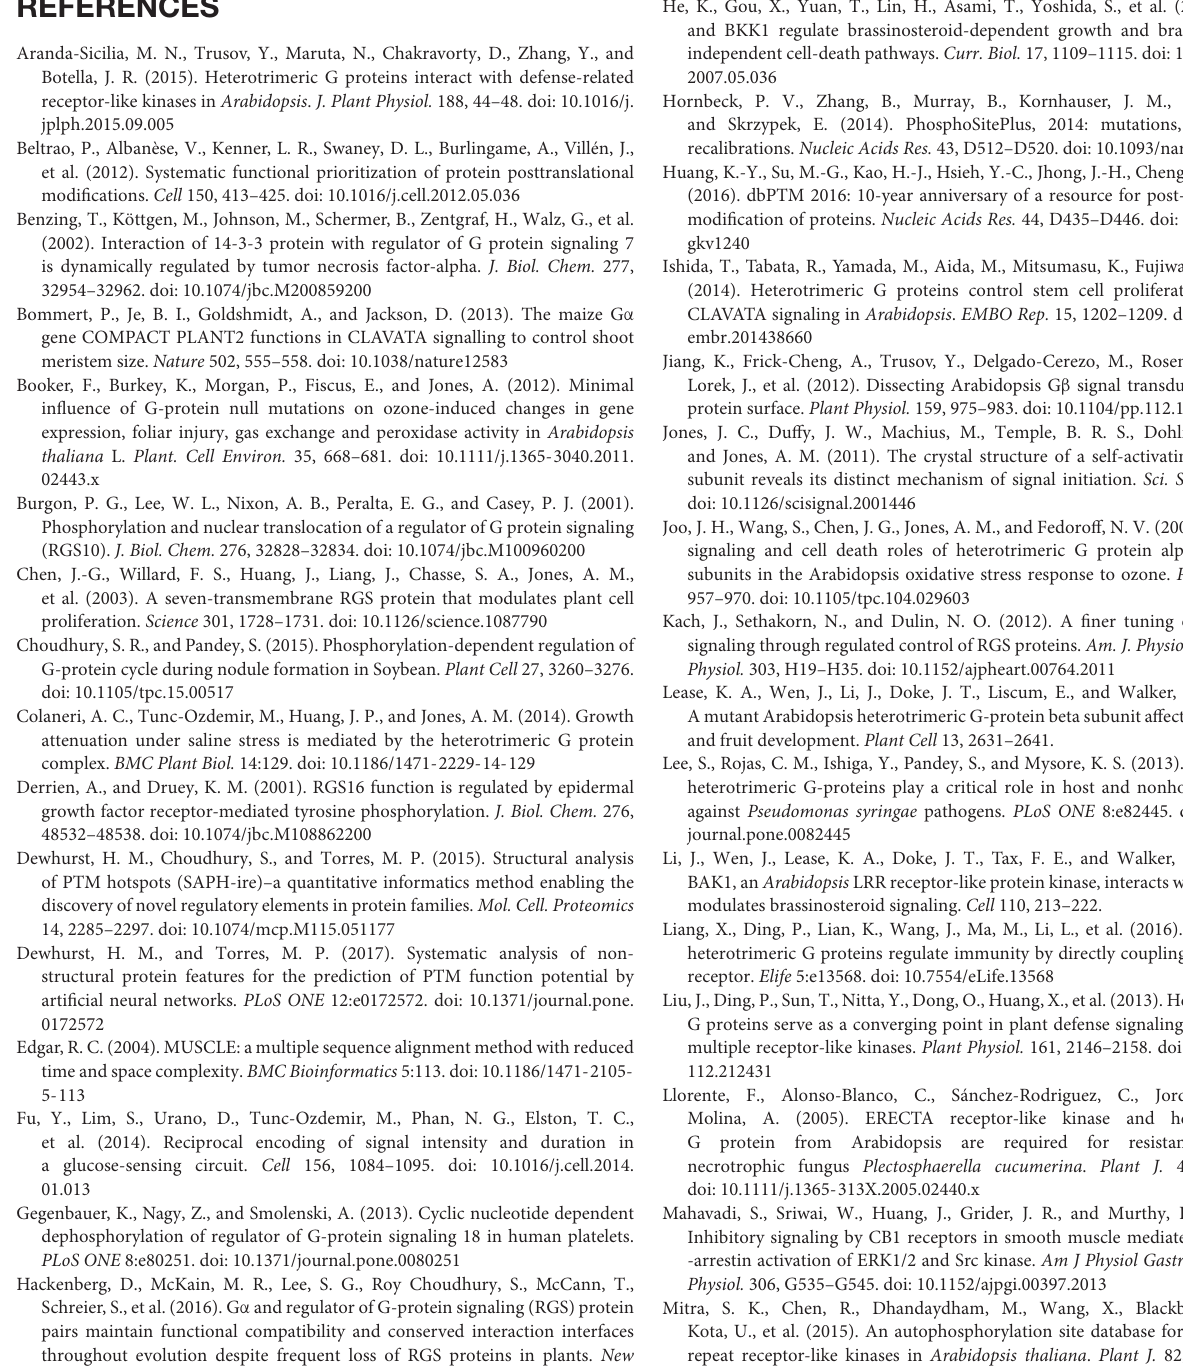
FIGURE S4 | Full rotation view of plant and non-plant MAPs projected onto the homology model of the AtRGS1 RGS domain. (A,B) Same as in Figure 5 , shown here for orientation. (C–F) Various rotation positions that allow full visualization of all RGS domain MAPs analyzed by SAPH-ire. MAPs harboring PTMs with biological function are labeled with the specific protein and position for the modified residue.